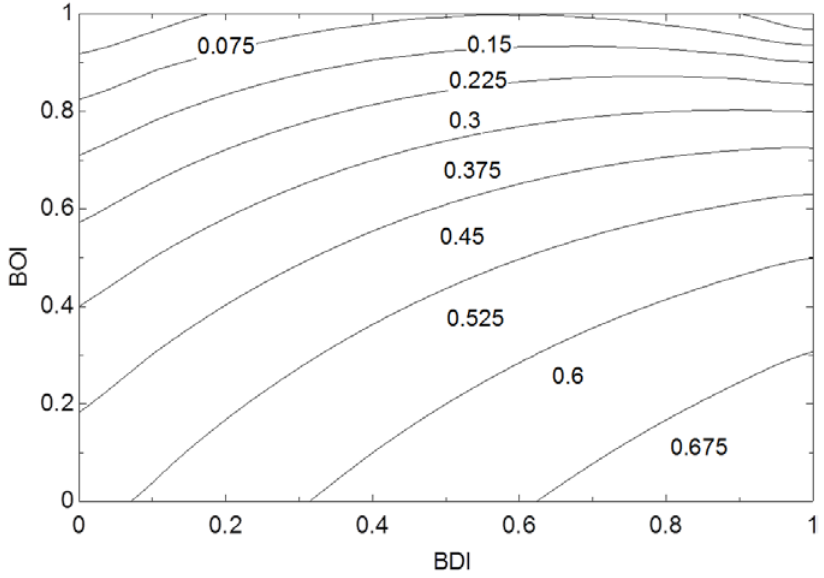
Figure 8. Building energy savings due to comprehensive